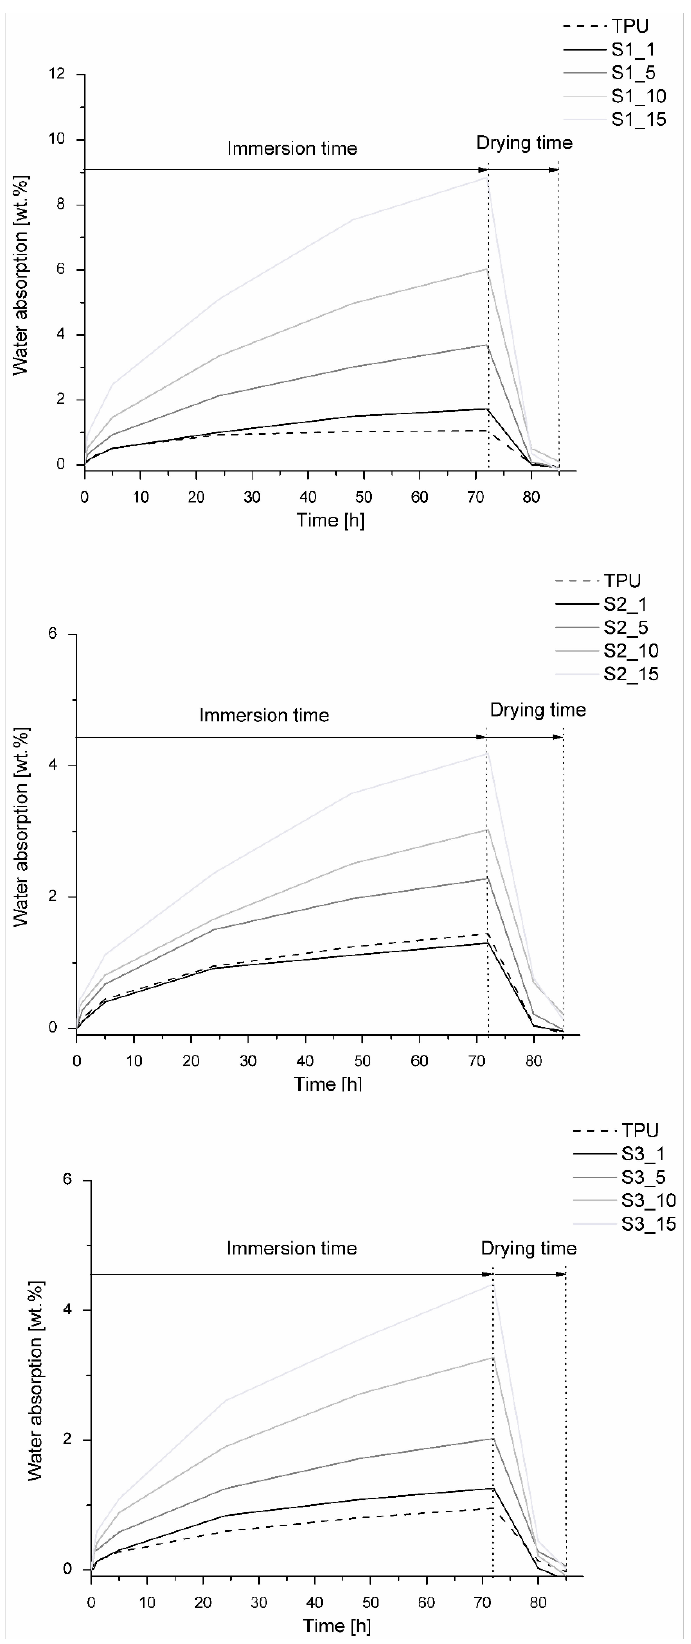
Figure 10. Water absorption graph for bio-TU matrices bio-TPU–ABW composite series S1, S2, and S3 during sample immersion in water and after drying.